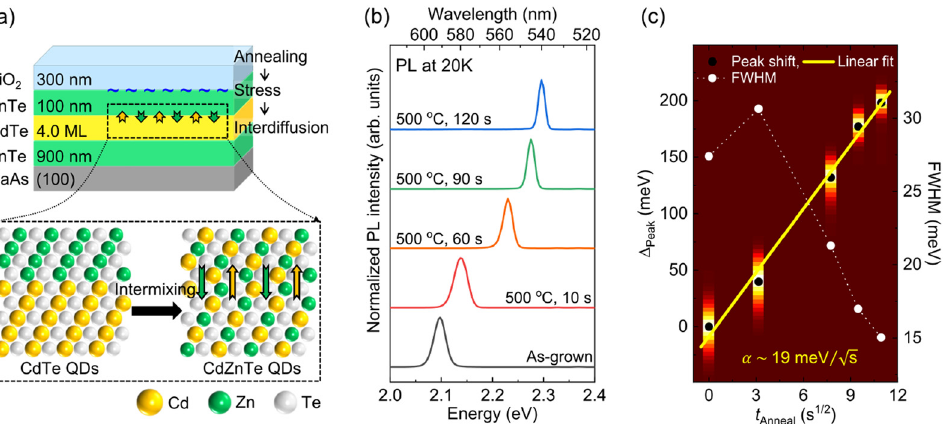
Figure 1: (a) Schematicof the structureof epitaxially grown CdTe/ZnTe QDs with a SiO 2 capping layerand an illustration of QD intermixingvia thermalannealing.(b)Normalizedlow-temperaturePLspectraofQDsampleswithdifferentannealingtimes.(c)PLpeakshiftandFWHMofthe CdTe/ZnTe QDs with respect to the annealing time. PL spectra of the fi ve samples are shown as background 2D contour images at each peak position. A linear relation between the PL peak shift and the square root of time is shown as a yellow line (slope α (cid:3) 19 ± 1 meV / quantum dot; PL,